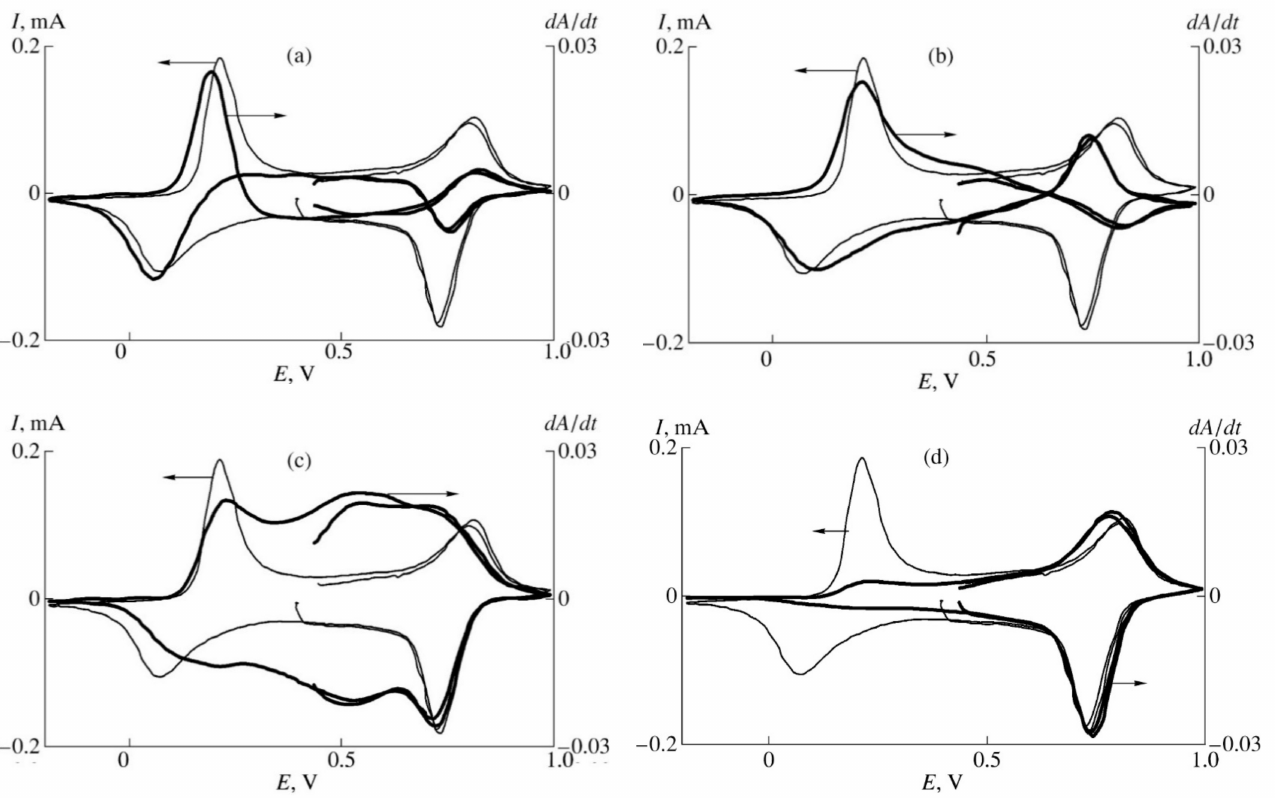
Figure 5. DCVA (thick lines) and CVA (thin lines) curves for PANI films measured in HClO 4 at ( a ) 435, ( b ) 755, ( c ) 665, and ( d ) 570 nm. Potential sweep rate is 10 mV/s. Reprinted by